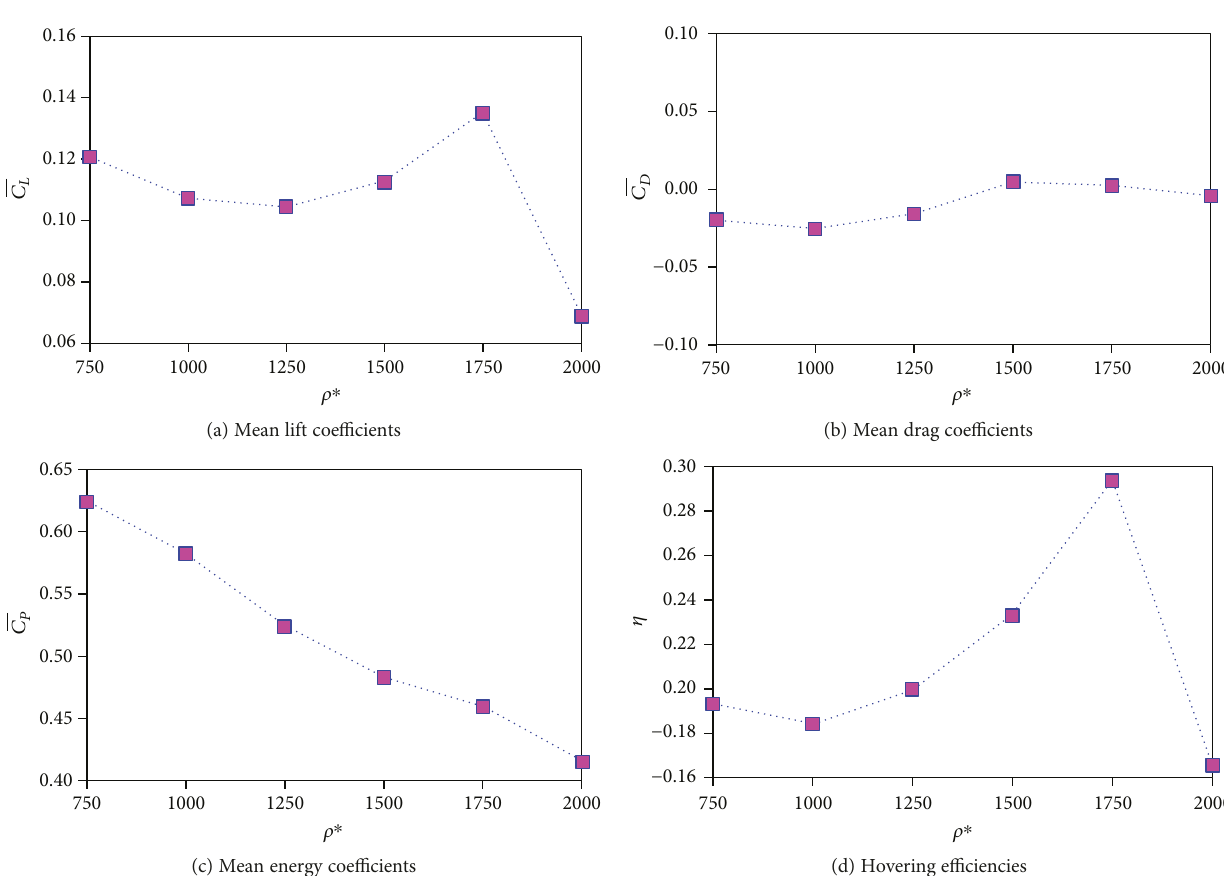
Figure 12: The performance of the 3D lumped fl exibility wing with di ff erent ρ ∗